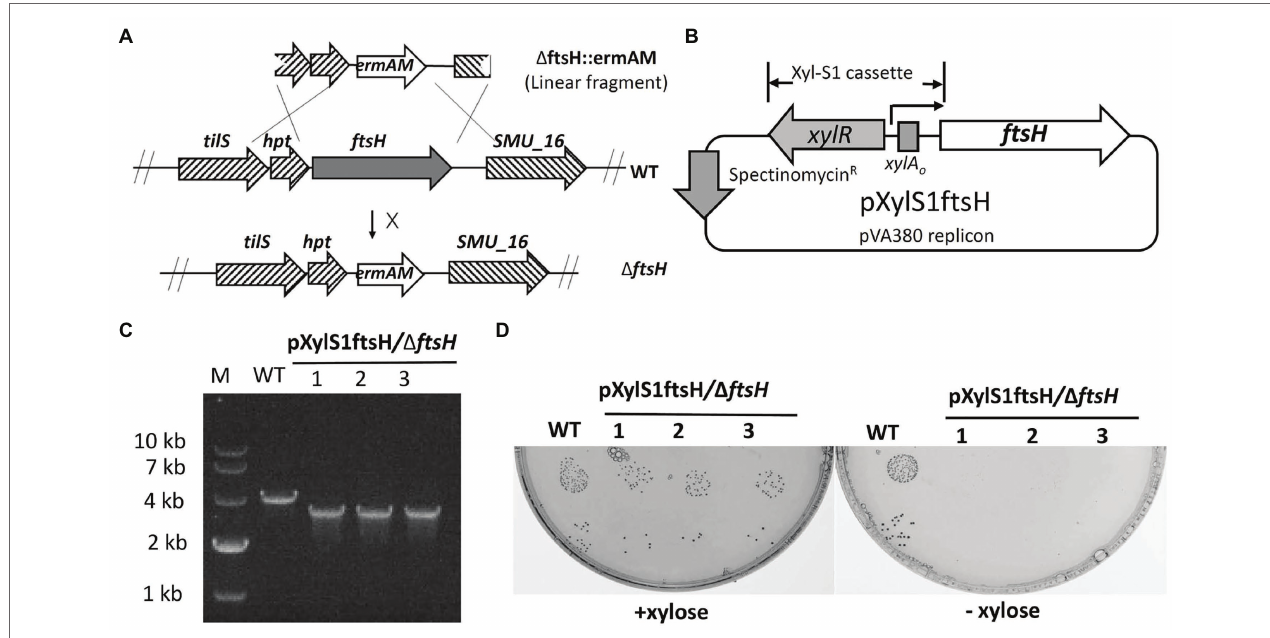
FIGURE 1 | Mutagenesis of ftsH . (A) Illustration of the allelic replacement scheme for ftsH mutagenesis. ftsH is the last gene of a seven-gene operon that also includes hpt (encoding a hypoxanthine phosphoribosyltransferase) and tils (encoding a tRNA lysidine synthetase). The X located adjacent to the arrow indicates an unsuccessful reaction. (B) Map of the inducible ftsH expression plasmid pXylS1ftsH. Expression of the ftsH gene in pXylS1ftsH is controlled by the xylose induction cassette Xyl-S1 (Xie et al., 2013b). (C) Three randomly selected transformants of strain pXylS1ftsH/UA159 were PCR amplified using primers flanking the ftsH